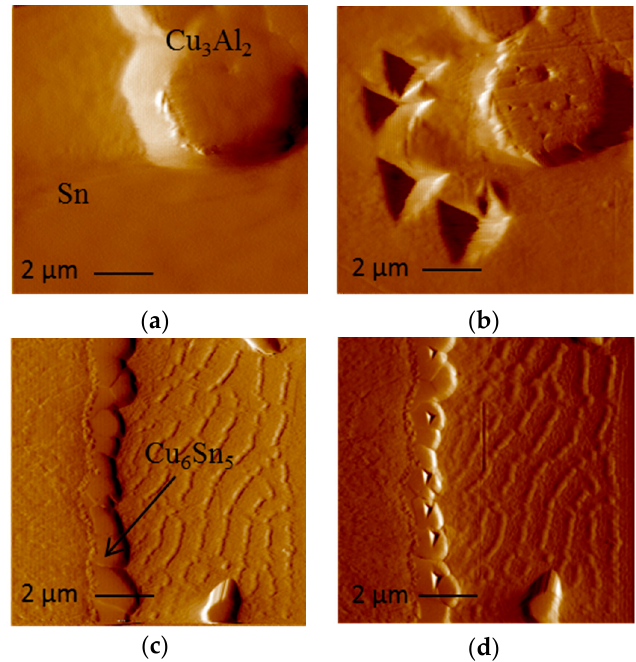
Figure 13. Scanning probe microscopy image of: ( a ) Sn and Cu 3 Al 2 before indentation; ( b ) Sn and Cu 3 Al 2 after indentation; ( c ) Cu 6 Sn 5 before indentation; and ( d ) Cu 6 Sn 5 after indentation of SAC105 + 0.1Al.